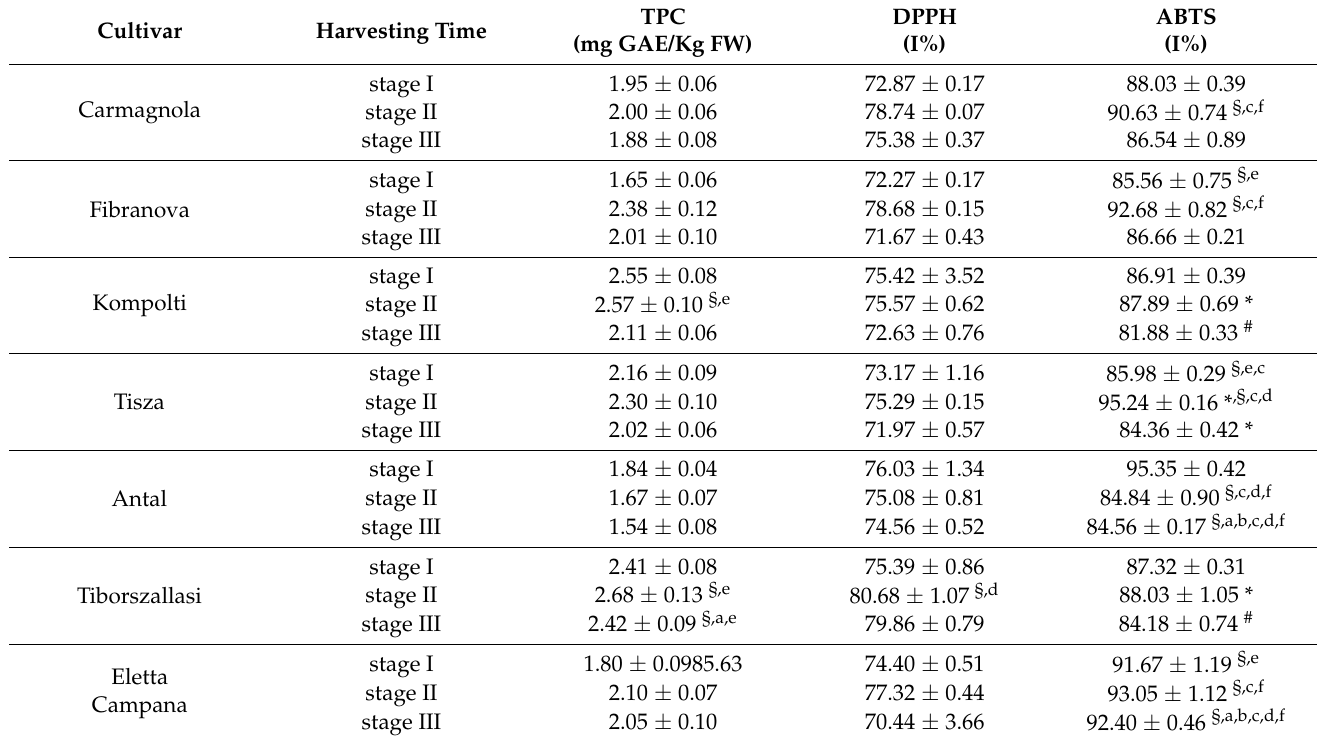
Table 3. Total phenolic content (TPC) and antioxidant activity by spectrophotometric analysis (mg/g of fresh inflorescences or inhibition rate (I%) ± SD) reported for each cultivar in different harvesting stages (stage I = 4 September, stage II = 14 September, stage III = 30 September). Analyses were carried out in triplicate.